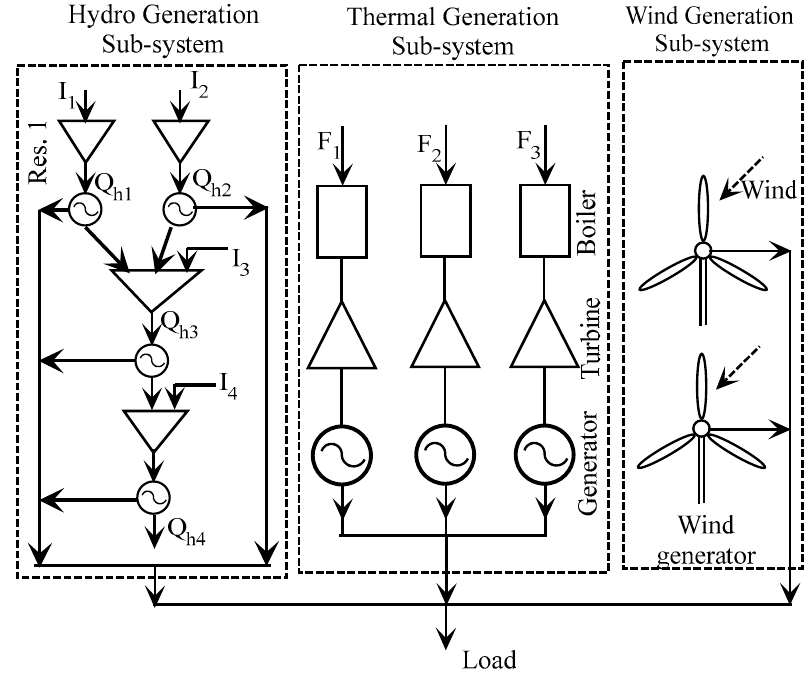
Figure 2. Schematic diagram of the hydro ‐ thermal ‐ wind test system.